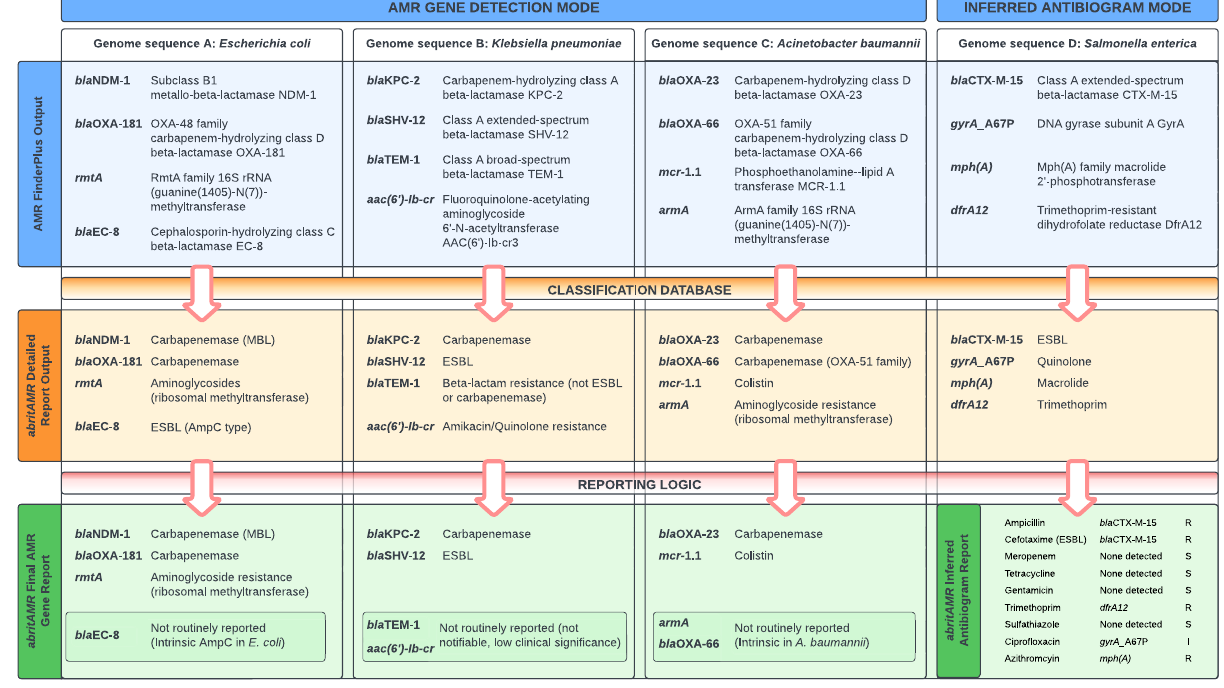
as noti fi able AMR mechanisms) from lower-priority groups, (iii) identi fi cation of clinically-relevant AMR mechanisms within a drug class (e.g. separation of ESBLs and AmpCs from genes encoding fi rst-generation cephalosporin resistance; separation of metallo-beta-lactamase (MBL) carbapenemases and other carbape- nemases due to differences in patient treatment), and (iv) application of tailored reportinglogictoseparatereportableandnon-reportablegenesaccordingtolocal requirements, thus de-cluttering the report for clinicians and public health teams. Note, only ‘ Exact ’ matches (100% sequence identity and coverage) and ‘ Close ’ matches (90-<100% identity and 90-<100% sequence coverage) from the AMRFin- derPlus tool are reported by abritAMR . Abbreviations: MBL, metallo-beta-lacta- mase; ESBL, extended-spectrum